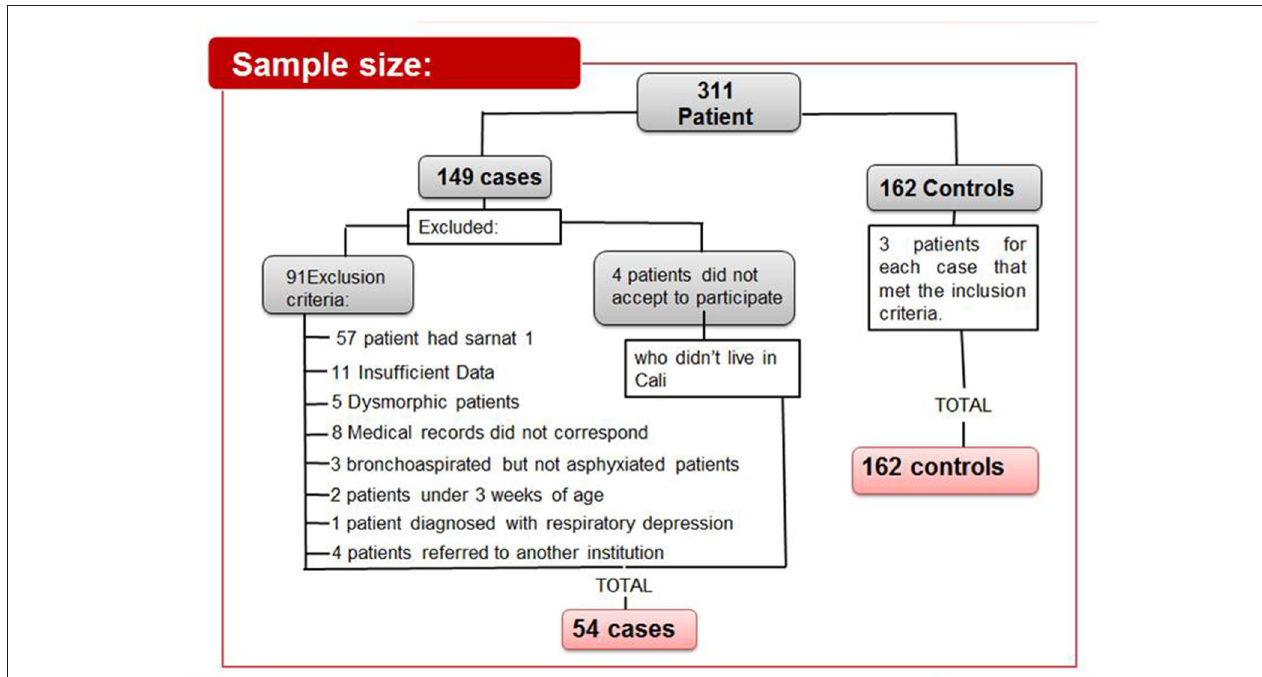
FIGURE 1 | Case selection scheme. Selection process of newborns from cases and